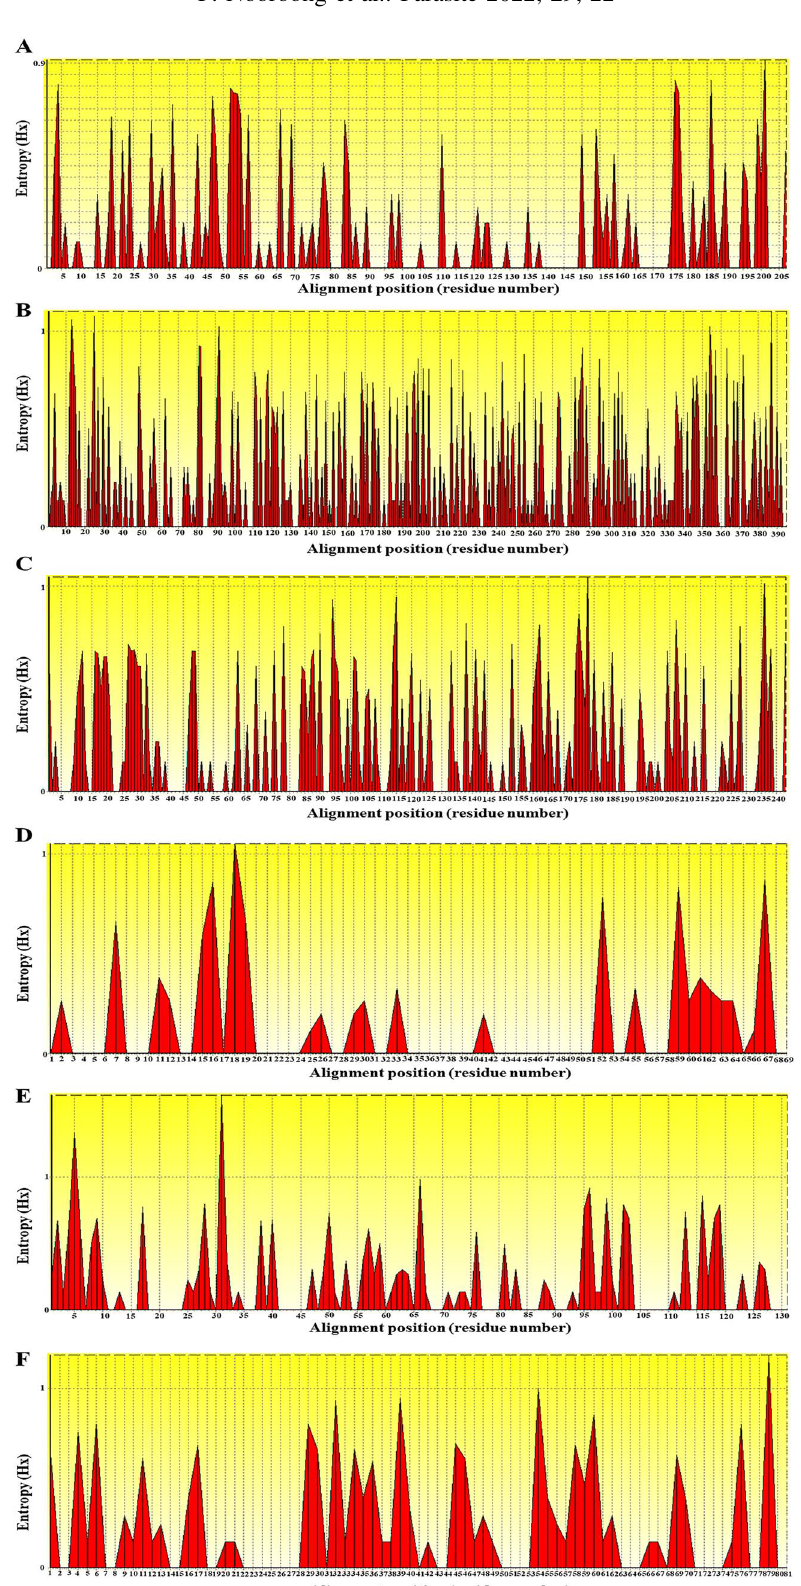
Fig. 5. Entropy analysis of L. sabrazesi cytb , coxI and coxIII gene sequences. Entropy plot of multiple nucleic acid sequence alignment of the cytb (A), coxI (B) and coxIII (C) genes. The red peaks indicate the high variation at each position of the nucleic acid sequences. Entropy plot of multiple amino acid sequence alignment of CYTb (D), COXI (E) and COXIII (F). The red peaks indicate the high variation at each position of amino acid